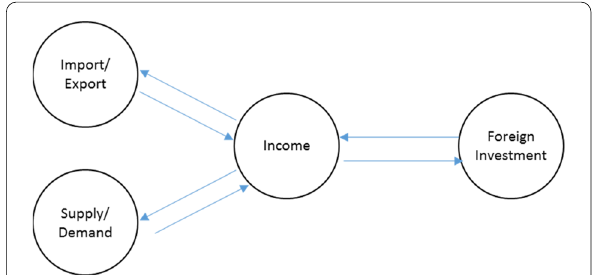
Fig. 3 Relationships between the basic subsystems